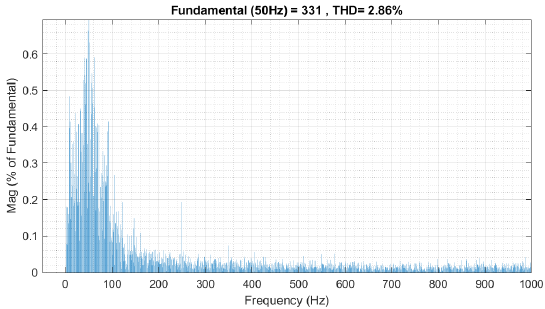
Figure 13. Transformer secondary/rectifier input current total harmonic distortion for three EV fast chargers.